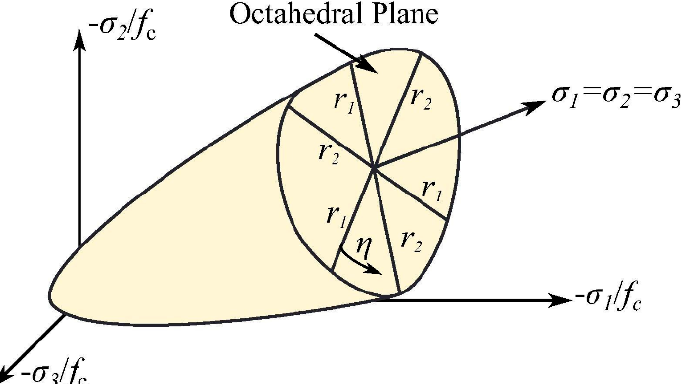
Figure 6. Three-dimensional WW failure surface in principal stress space (Reprinted with the permission from Ref. [46]. 2018, Elsevier Ltd.). In this representation, σ 1 , σ 1 , σ 3 , and f c are the three principal stresses and the uniaxial crushing strength, respectively.